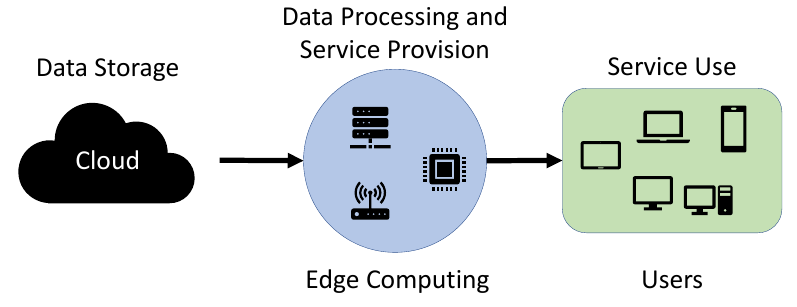
Figure 1. Edge computing